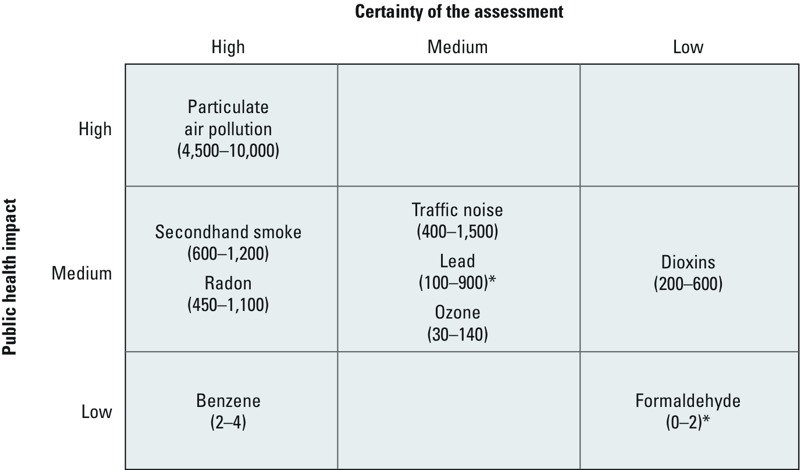
Ranges for the estimated contributions of the selected environmental risk factors to the burden of disease (DALYs per million people) as population-weighted averages over the six participating countries. Numerical values indicate nondiscounted DALYs per million people in the six participating countries.The figure is adapted from Hänninen and Knol (2011) with permission from the copyright holders.
*A numerical model was used to estimate threshold exceedances.